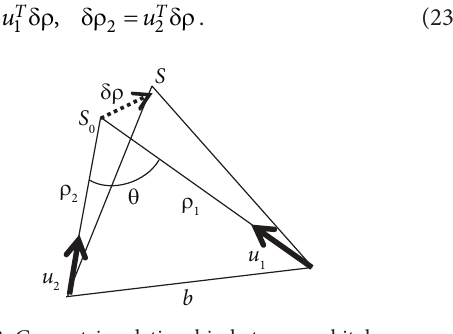
Figure 3. Geometric relationship between orbital error, receiver-satellite distance, baseline and the angle between